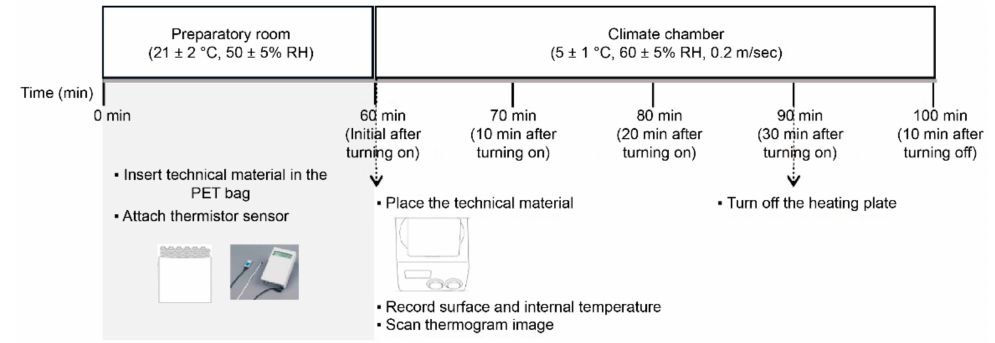
Experimental protocol for measuring the surface and internal temperatures of the technical